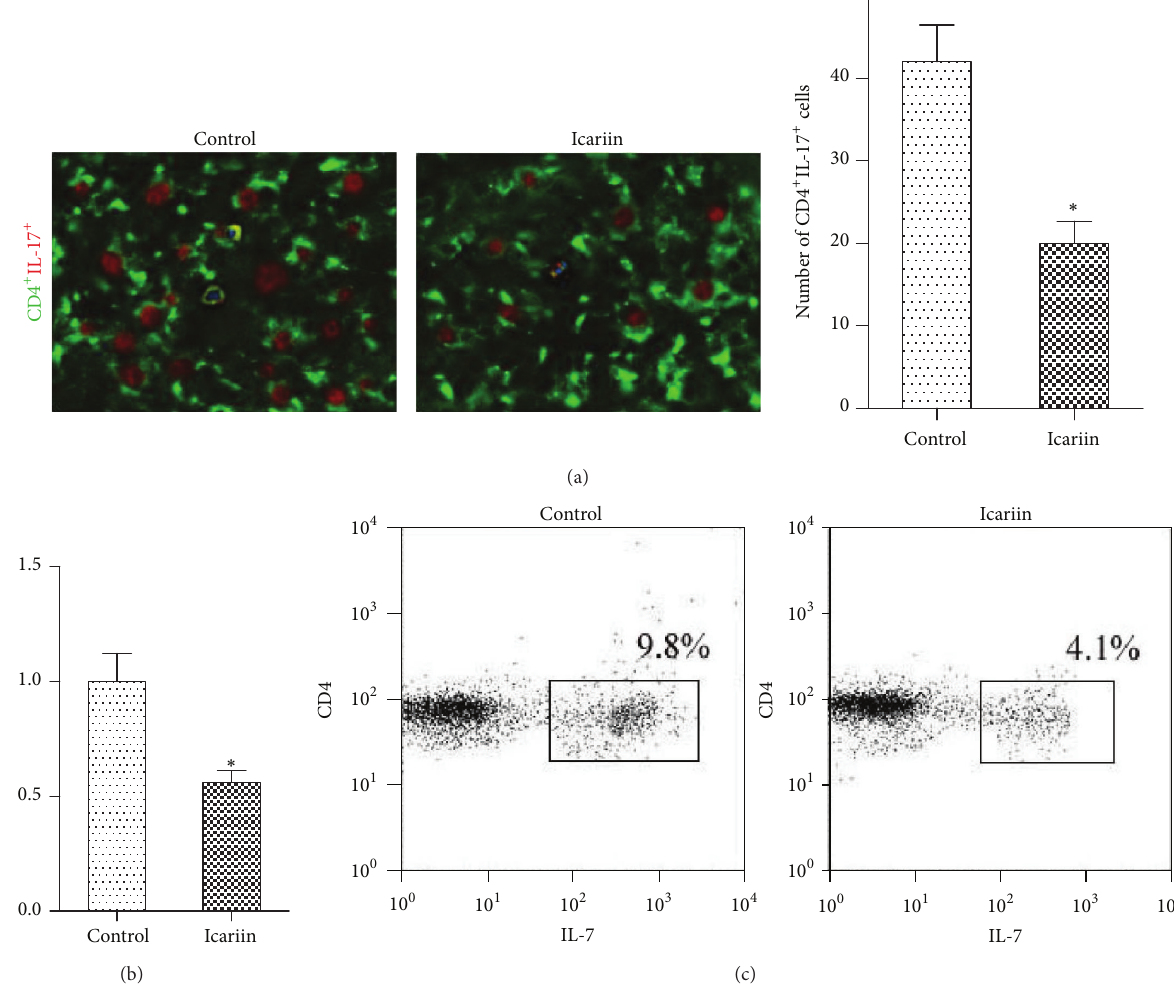
Figure 2: Icariin decreases Th17 cells and represses IL-17 production in vivo . (a) Samples of spleen tissue from mice treated with icariin or control were stained for CD4 + IL-17 + T cells. (b) Expression of IL-17 mRNA was determined using real-time PCR in splenocytes from mice with CIA in each group. (c) Flow cytometry analysis of the synovial CD4 + IL-17 + T cell subset in mice with CIA in each group. ∗ 𝑃 < 0.05 versus all other groups, 𝑛 = 6